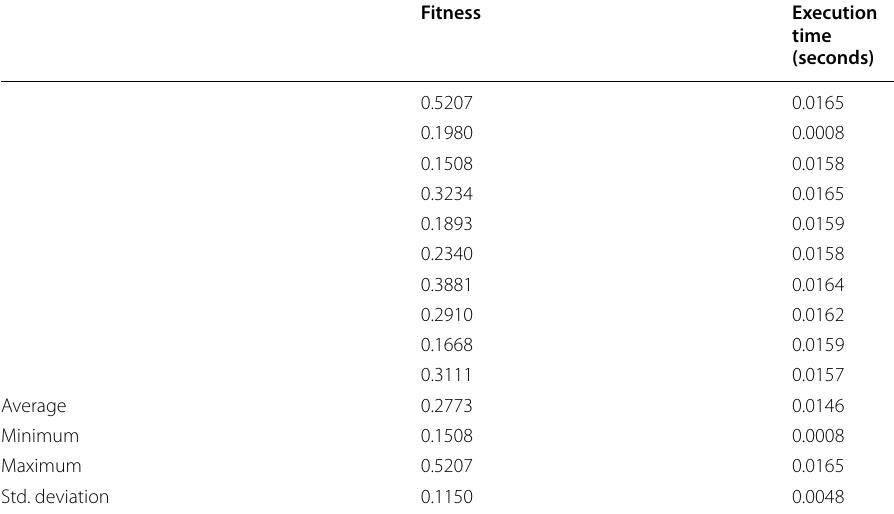
Table 5 Offline experiment